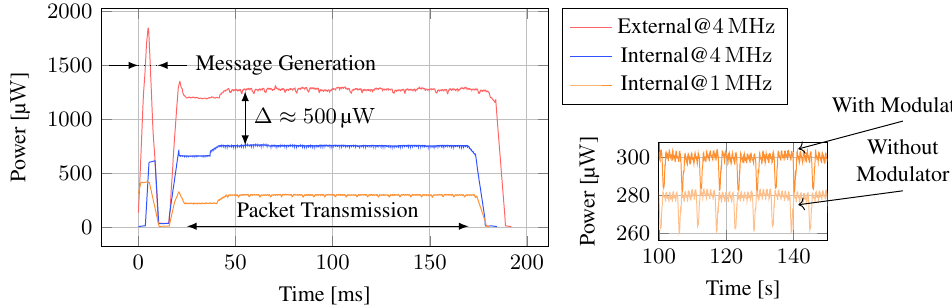
Figure 12. The power consumption of the tag MCU with different oscillators. External crystal oscillators at equivalent frequencies consume significantly more power than the low-power internal oscillator. The backscatter modulation itself only consumes around 20 µ W.